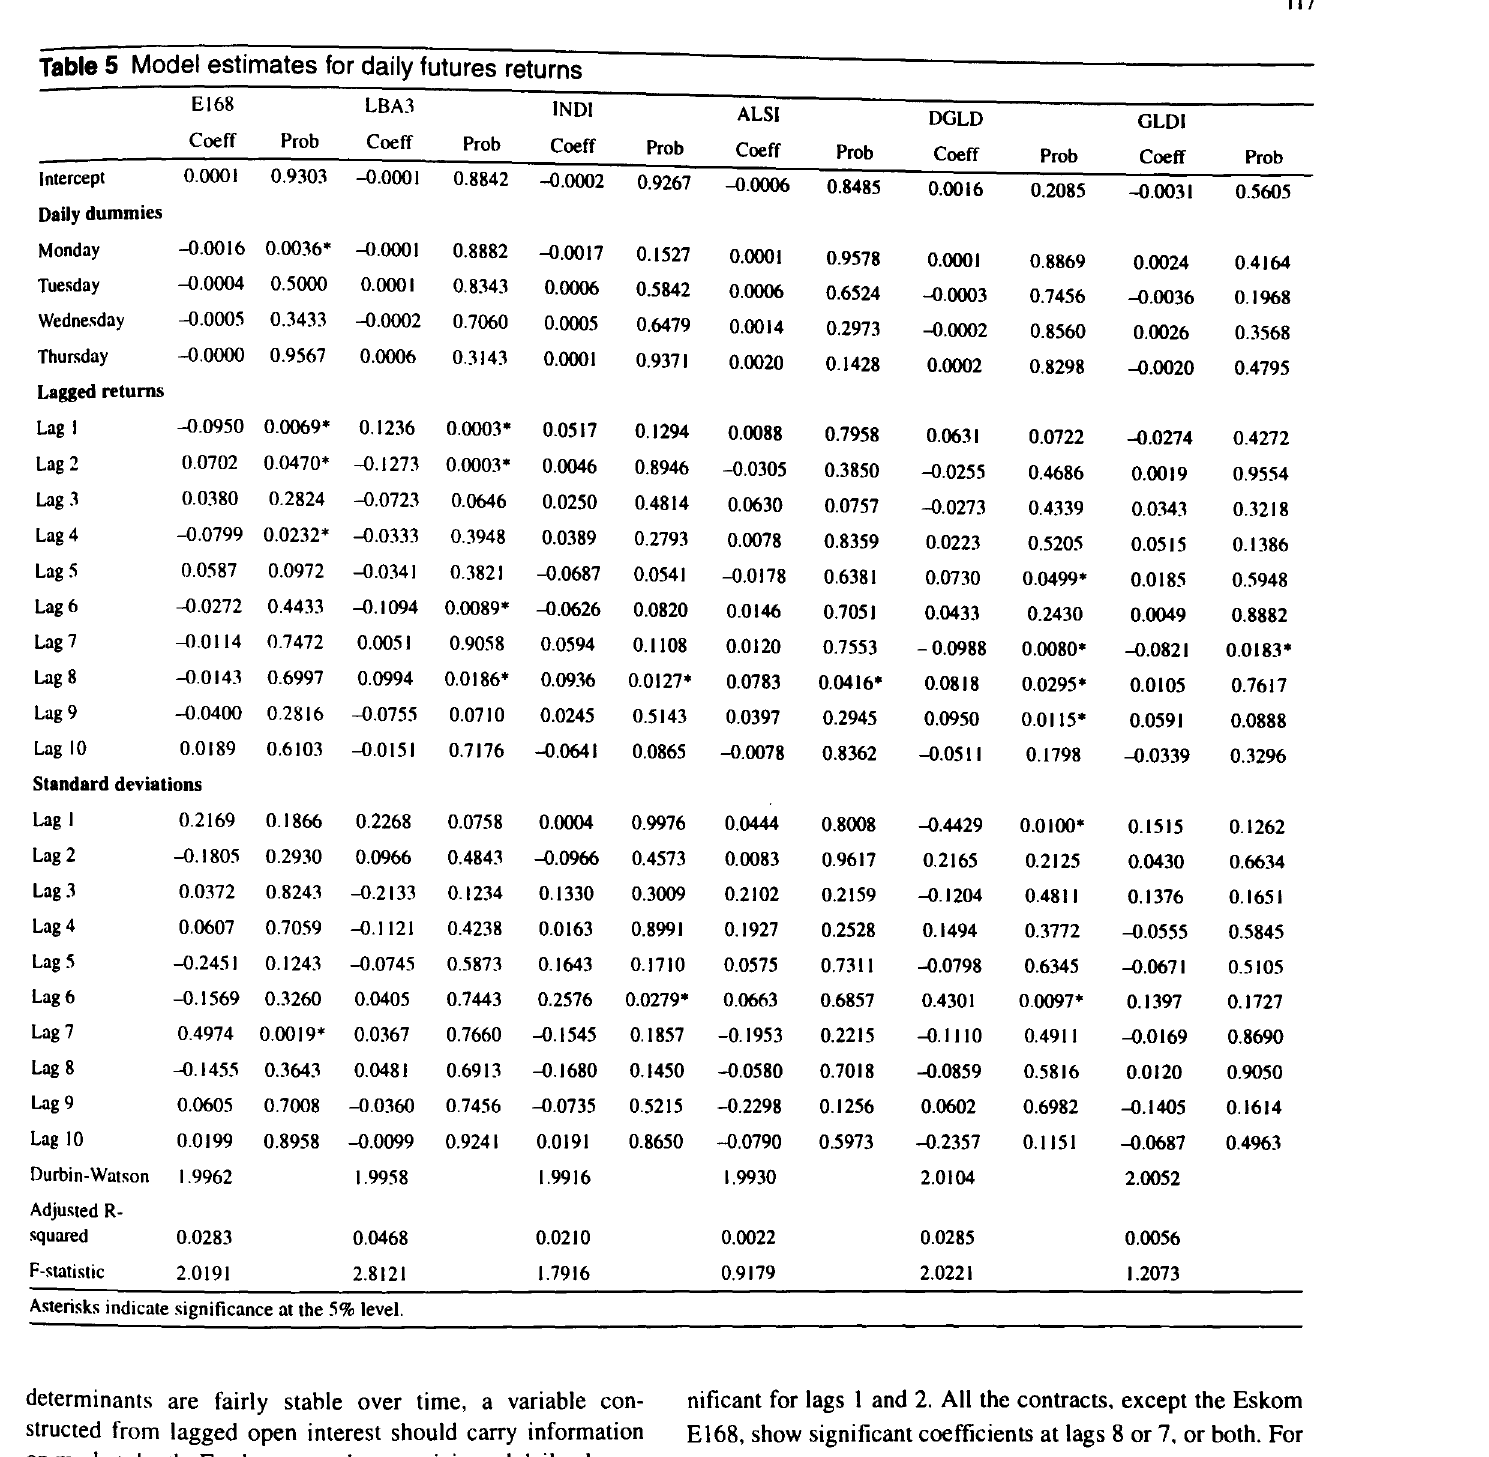
Table 5 Model estimates for daily futures